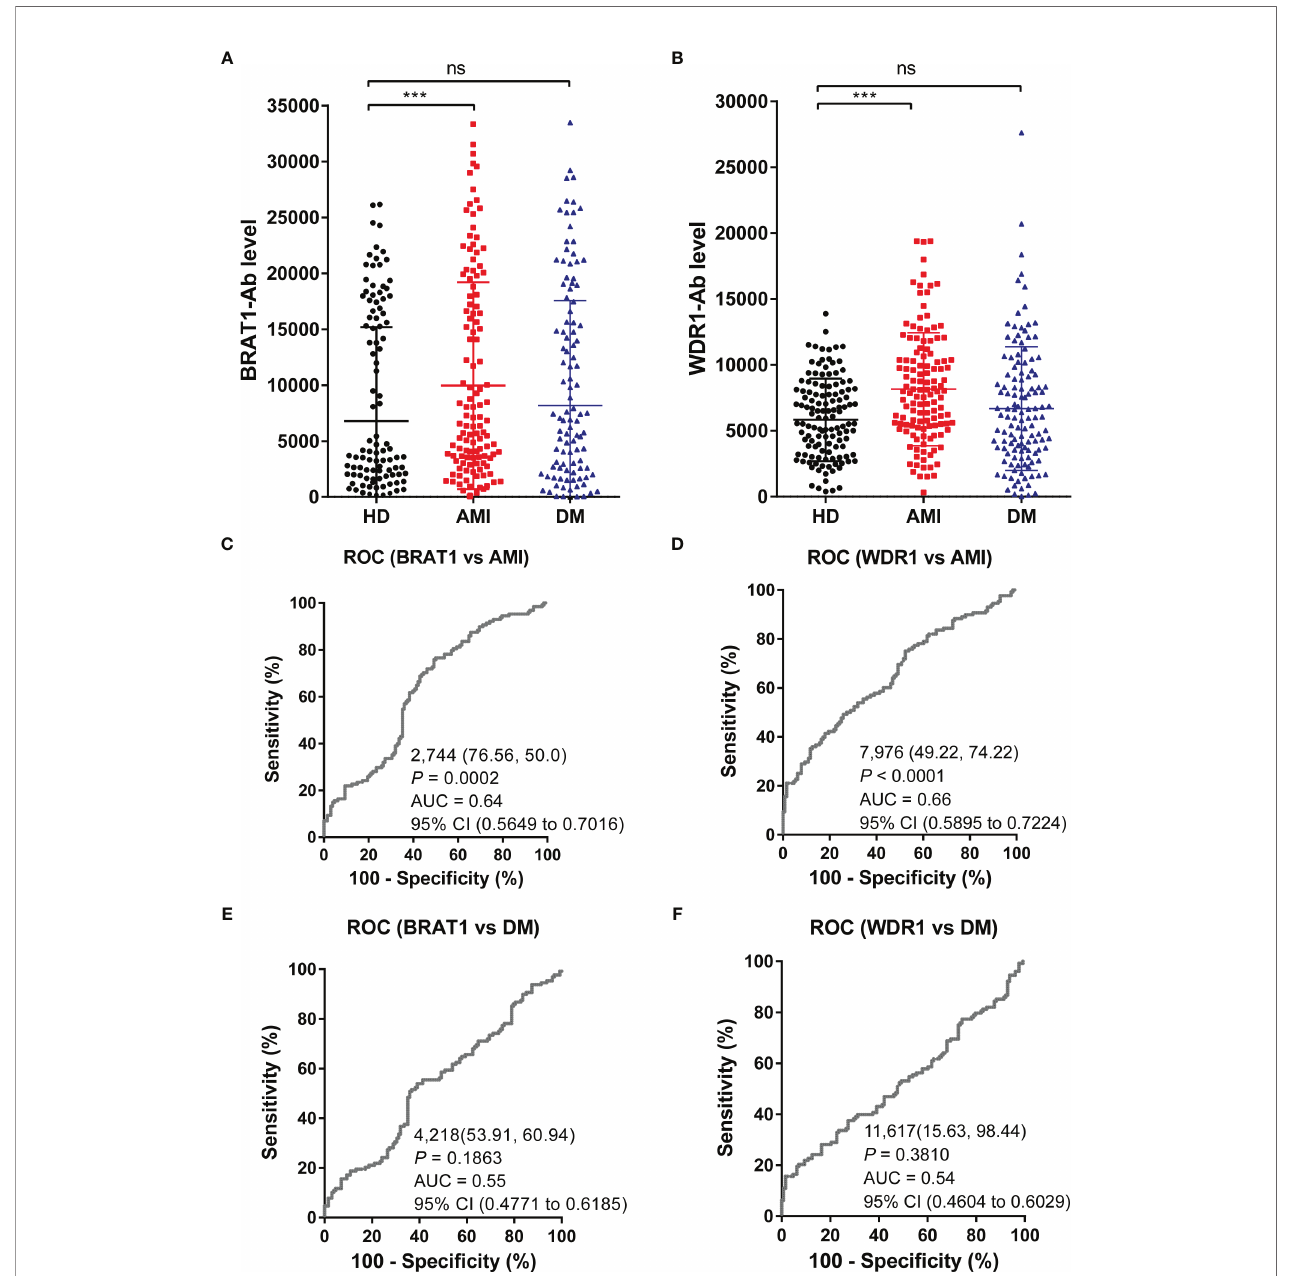
FIGURE 3 | Comparison of serum BRAT1-Abs and WDR1-Abs levels between HDs and patients with AMI or DM. Serum antibody levels against BRAT1-GST (A) or WDR1-GST (B) were detected by AlphaLISA. The bars represent the median. P values were calculated by the Kruskal – Wallis test. *** P < 0.001. ns, not signi fi cant. The serum number of HDs, AMI, and DM was 128. ROC analysis of BRAT1 and WDR1 for the prediction of AMI (C, D) and DM (E, F) . The numbers in the fi gures indicate the cutoff values for marker levels, and the numbers in parentheses indicate the sensitivity (left) and speci fi city